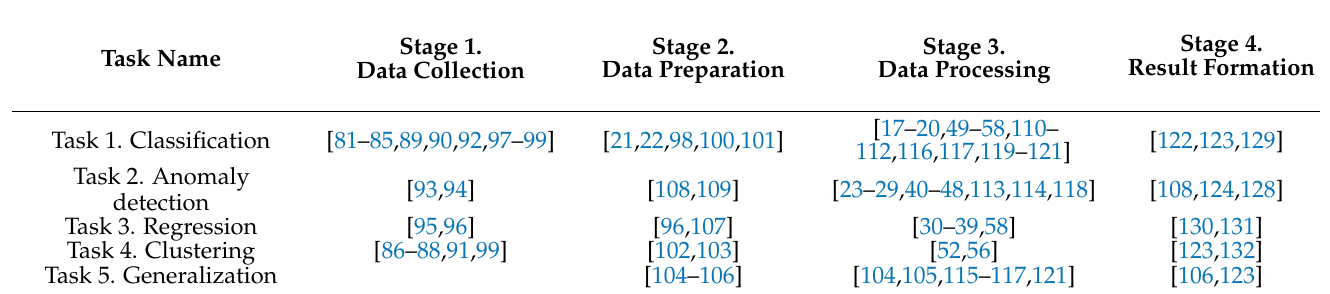
Table 6. Overview model of scientific works on the implementation of the static analysis stages using machine learning.